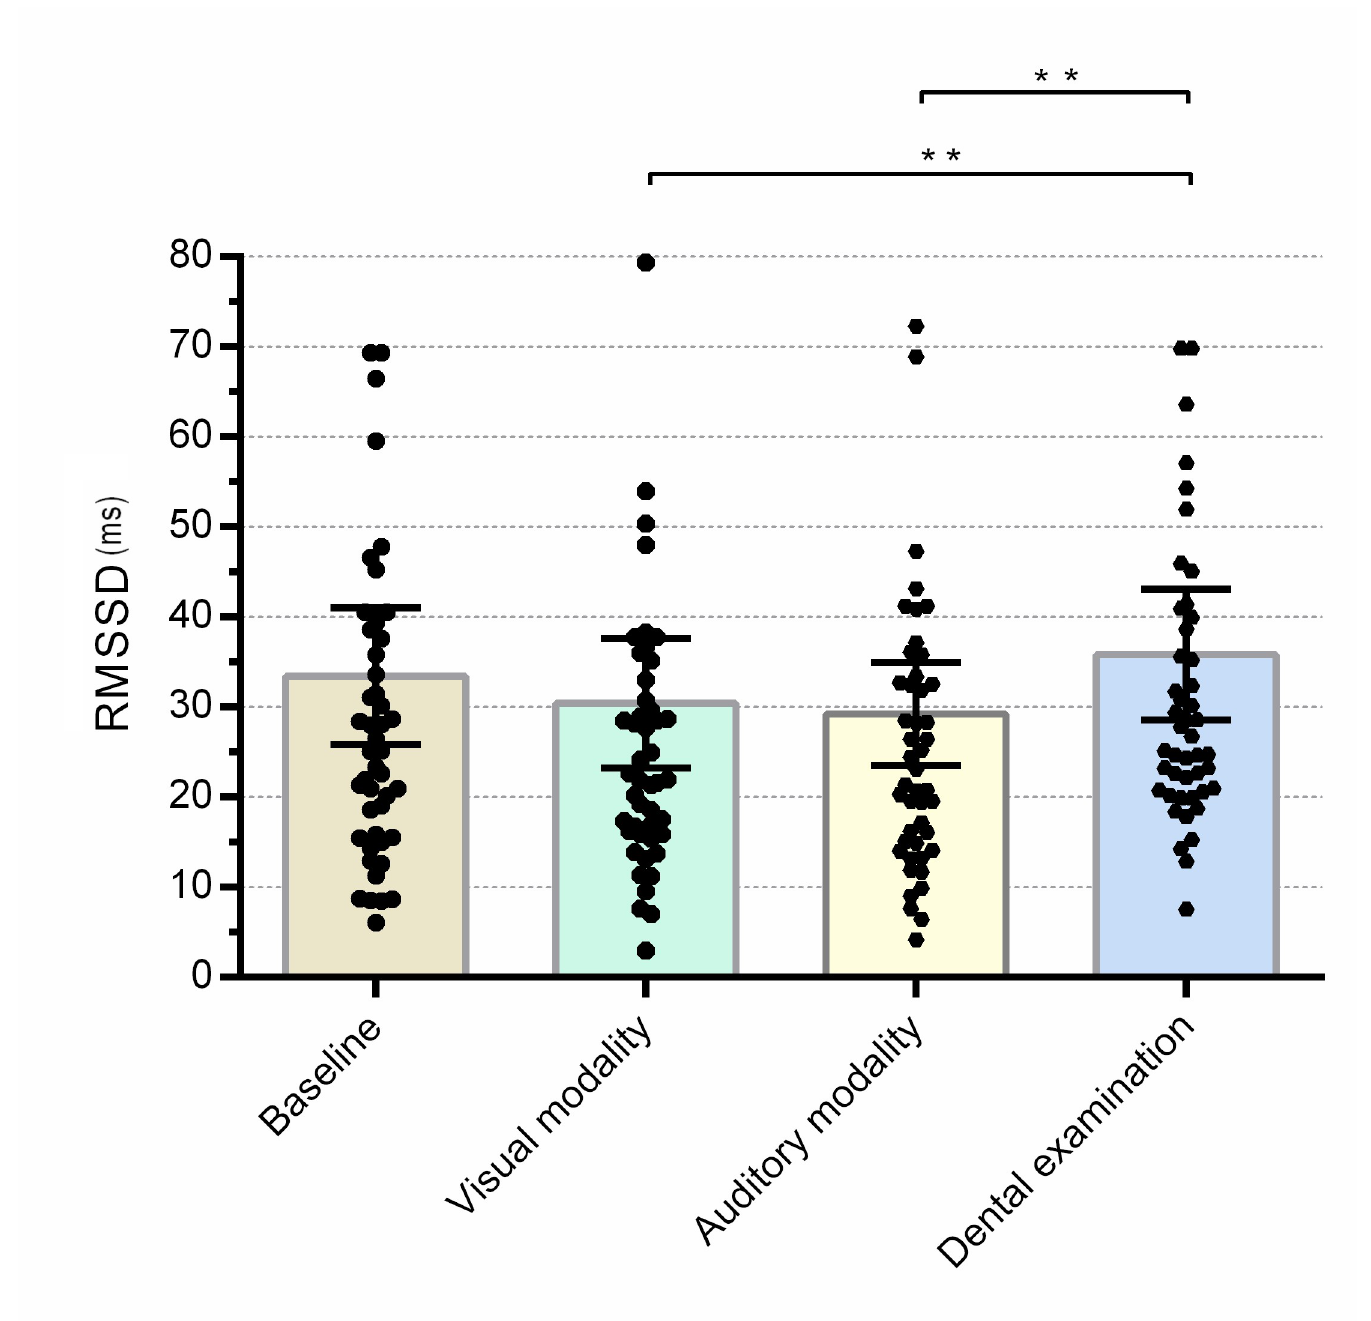
Fig 4. Mean heart rate variability as RMSSD during different experimental conditions. Error bars indicate a 95% confidence interval; �� p < 0.05; units are in